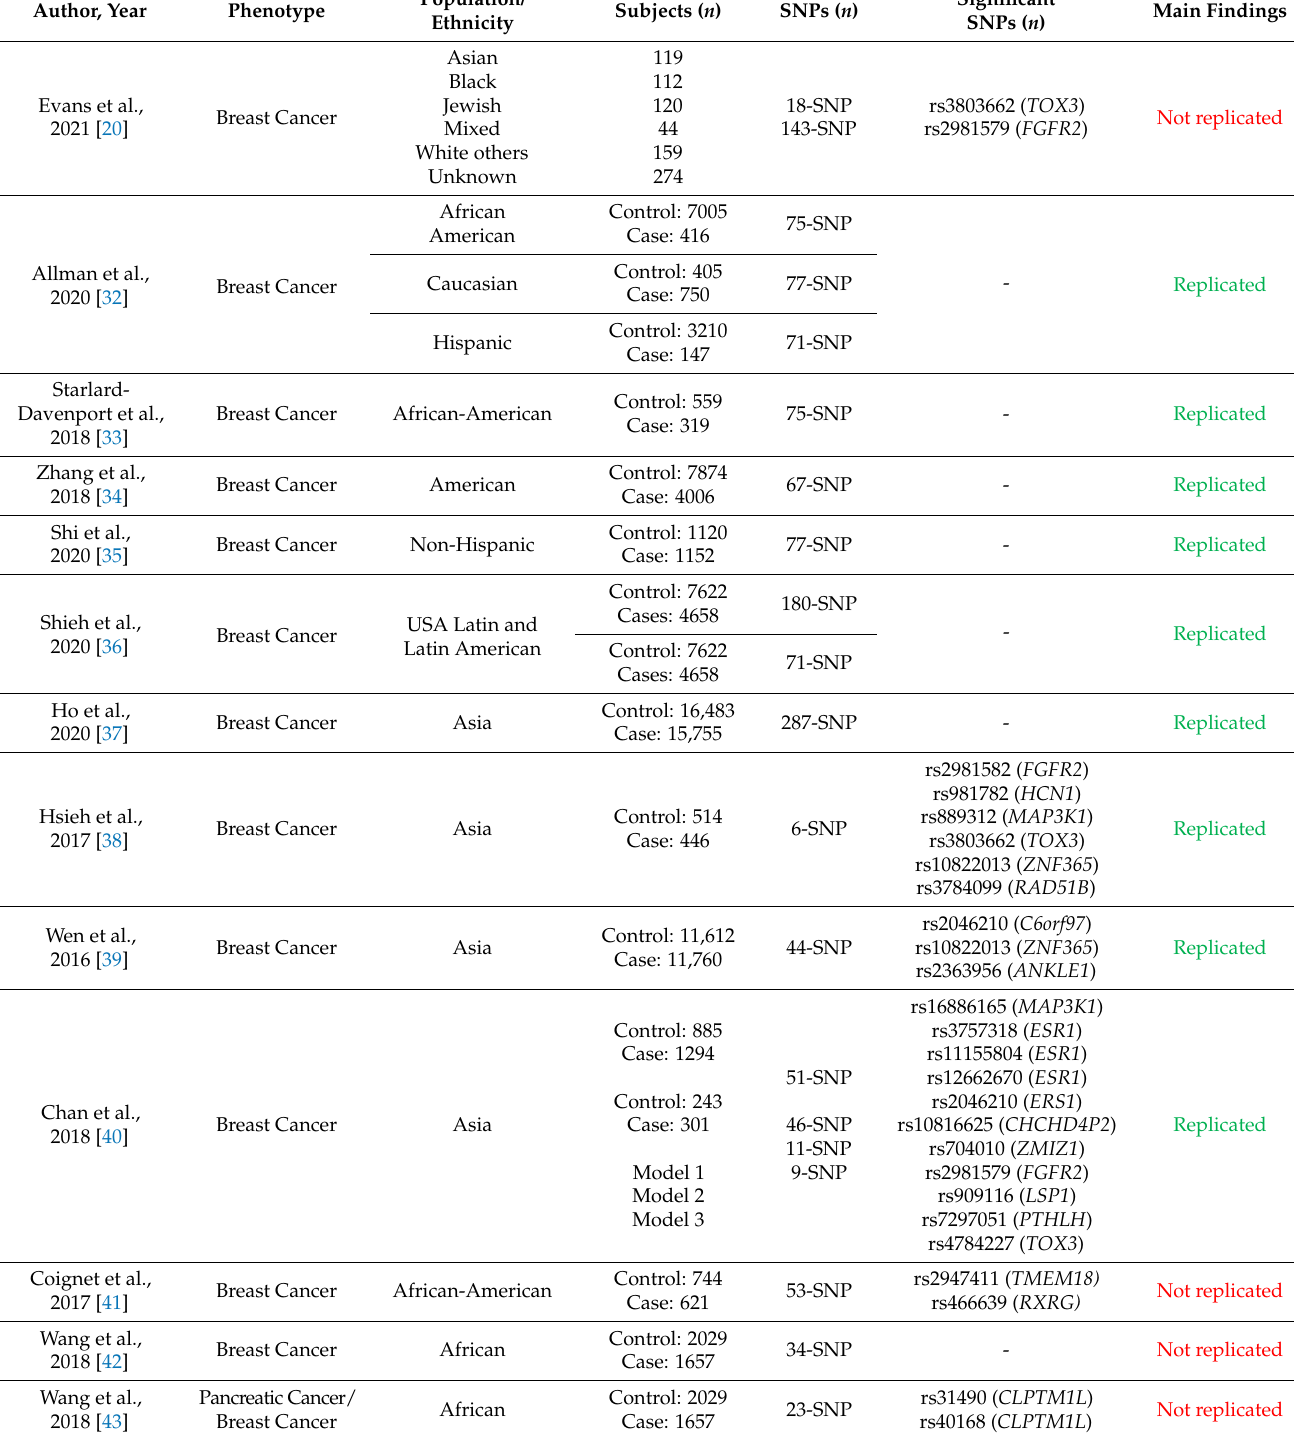
Table 1. Polygenic risk scores established for breast cancer in multiethnic